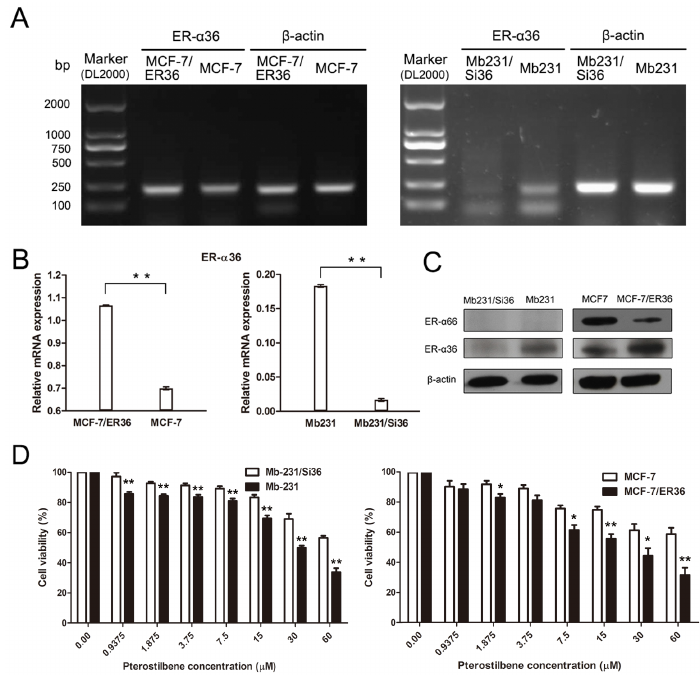
Figure 1. High ER- a 36 expression sensitizes breast cancer cells to pterostilbene treatment. a . ER- a 36 mRNA levels were measured in Mb231, Mb231/Si36, MCF-7, and MCF-7/ER36 cells using RT-PCR. b . The relative mRNA expressions are presented as the ratio of the OD of the corresponding mRNA bands compared to the OD of the b -actin bands. c . Western blots of ER- a 36 and ER- a 66 proteins in Mb231, Mb231/Si36, MCF-7, and MCF-7/ER36 cells using b -actin levels as the loading control. d . MTT assays measuring the cell proliferation of the two paired cells after control and pterostilbene treatments for 72 h. The relative cell numbers were normalized to those of their respective pterostilbene untreated controls (set as 100%). (Bars, SE. * p , 0.05, ** p , 0.01). doi:10.1371/journal.pone.0104459.g001 genomic signaling via ER- a 36. The MAPK/ERK and PI3K/Akt phosphorylation levels in pterostilbene-treated Mb231, Mb231/